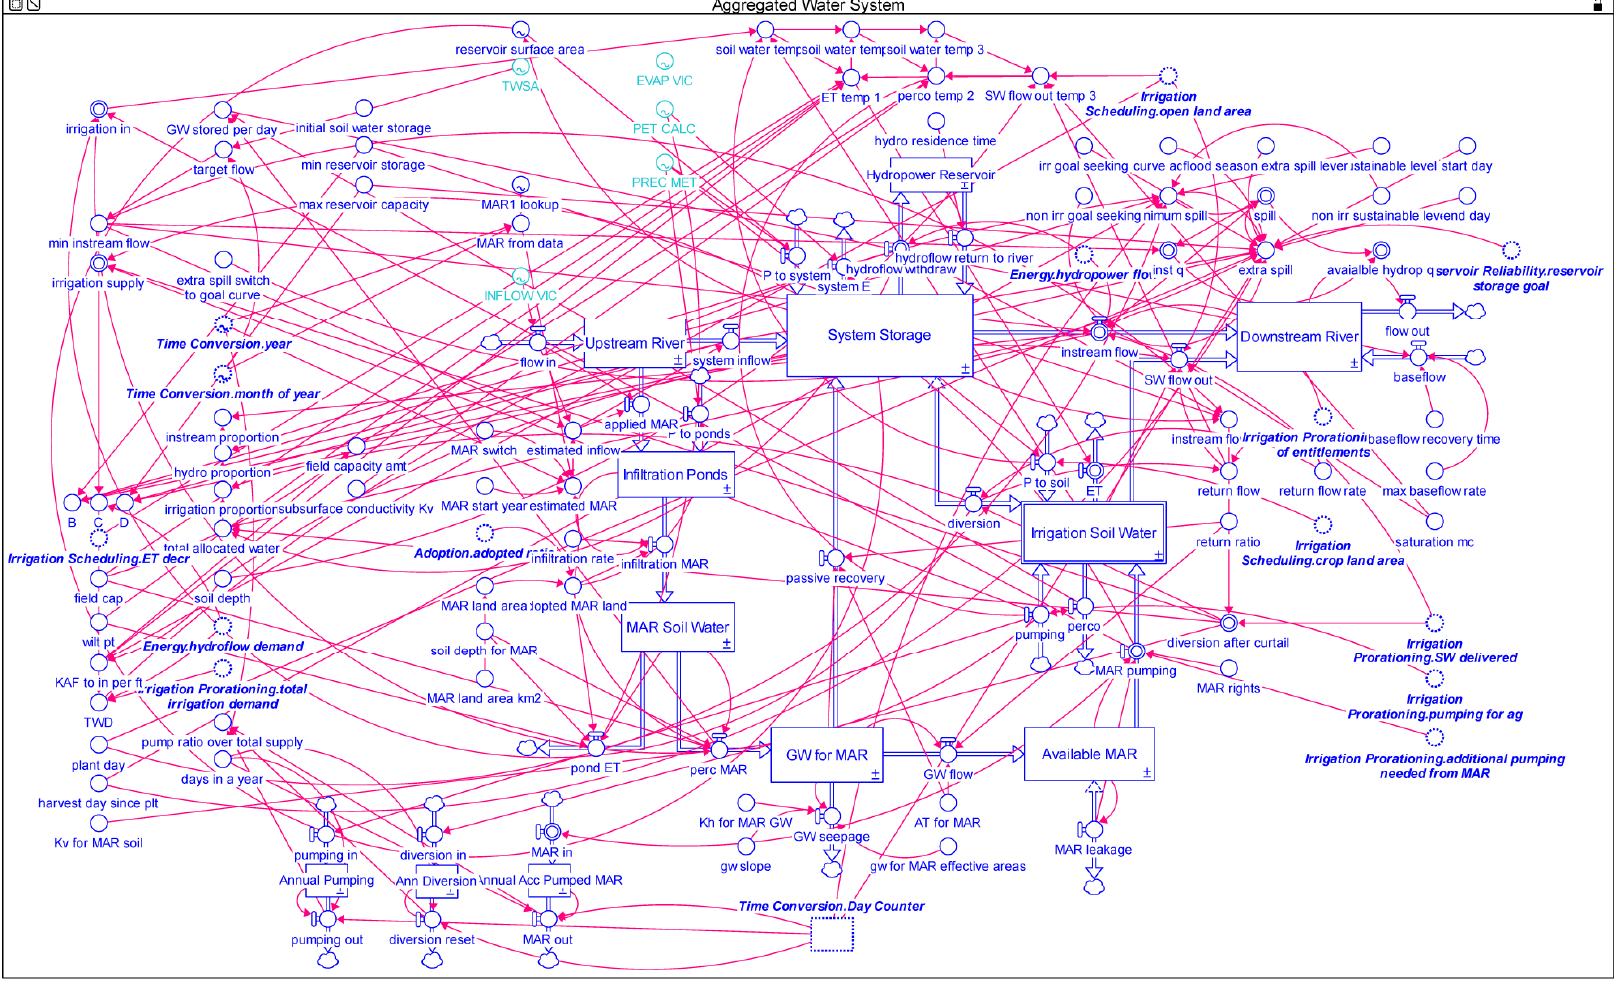
Figure A4. System dynamics model structure for aggregated water